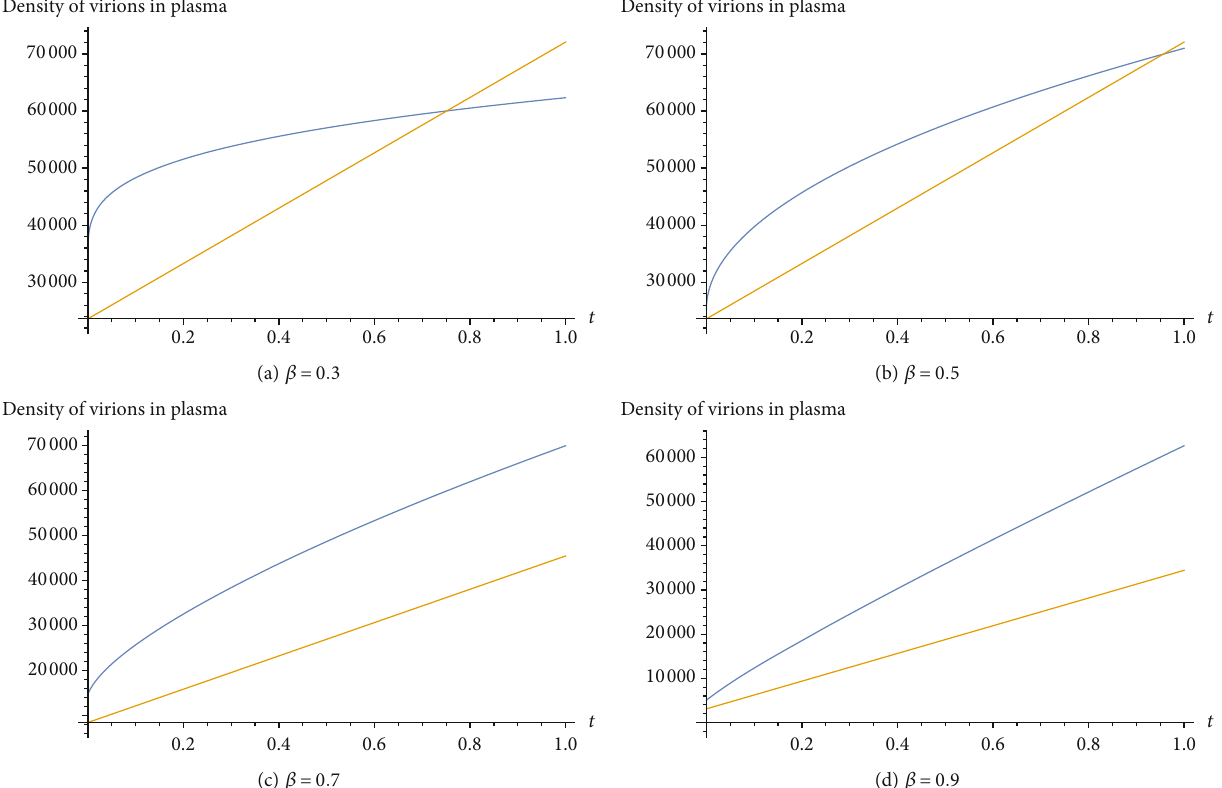
Figure 5: The comparison of the behavior of density of virions in plasma in Caputo-Fabrizio and Atangana Baleanu sense for di ff erent order fractional derivatives, where blue colour represents graph for ABC operator and orange represents graph for CF